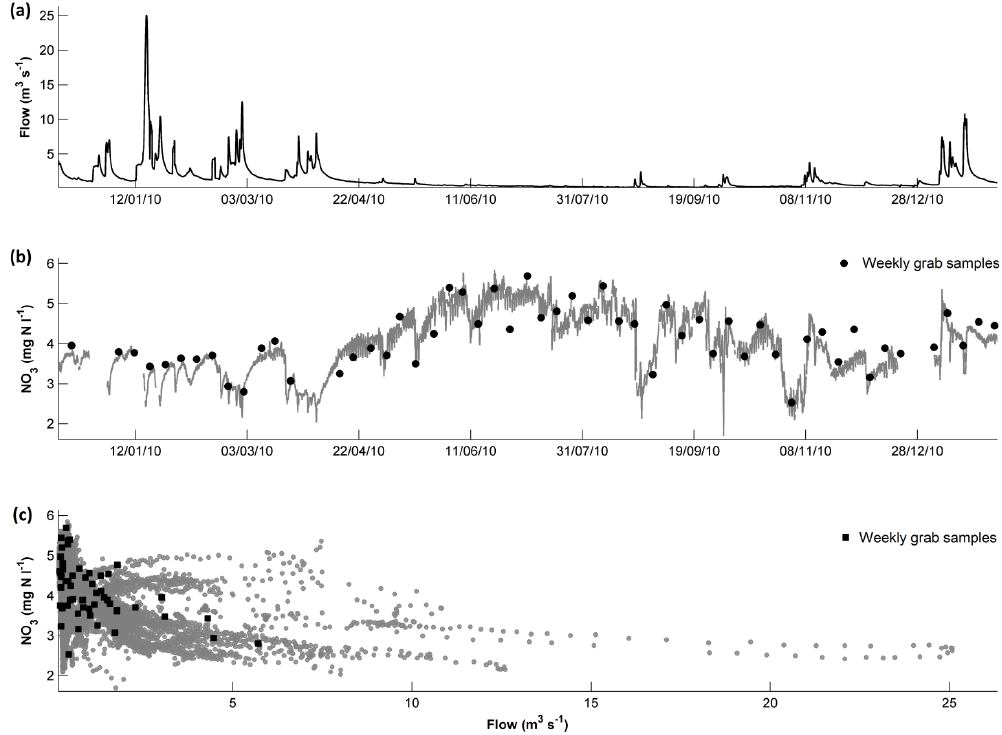
Fig. 5. River Enborne (a) flow (m 3 s − 1 ), (b) streamwater NO 3 concentration (mgNl − 1 ) and (c) scattergram of streamwater NO 3 concentra- tion and